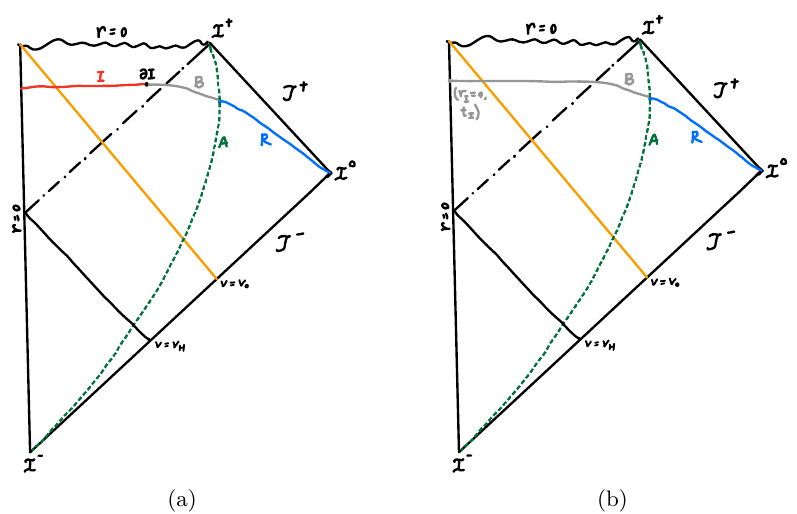
Figure 1 . (a) The Penrose diagram for one-sided black hole formed by spherical null shell collapsing at v = v 0 (orange line) [7]. Observer on cutoff surface A (green dashed line) collects Hawking radiation in region R . Island (red line) penetrates into interior of black hole. ∂I is quantum extremal surface. I ∪ B ∪ R is a Cauchy slice. (b) Without island, we can equivalently fix r I = 0 and t I as some